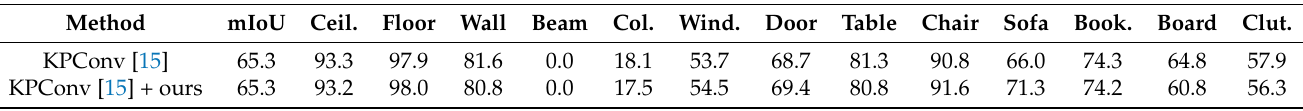
Table 9. Comparison between the results of KPConv [15] and ours in the semantic segmentation task on the S3DIS dataset [24] (Area